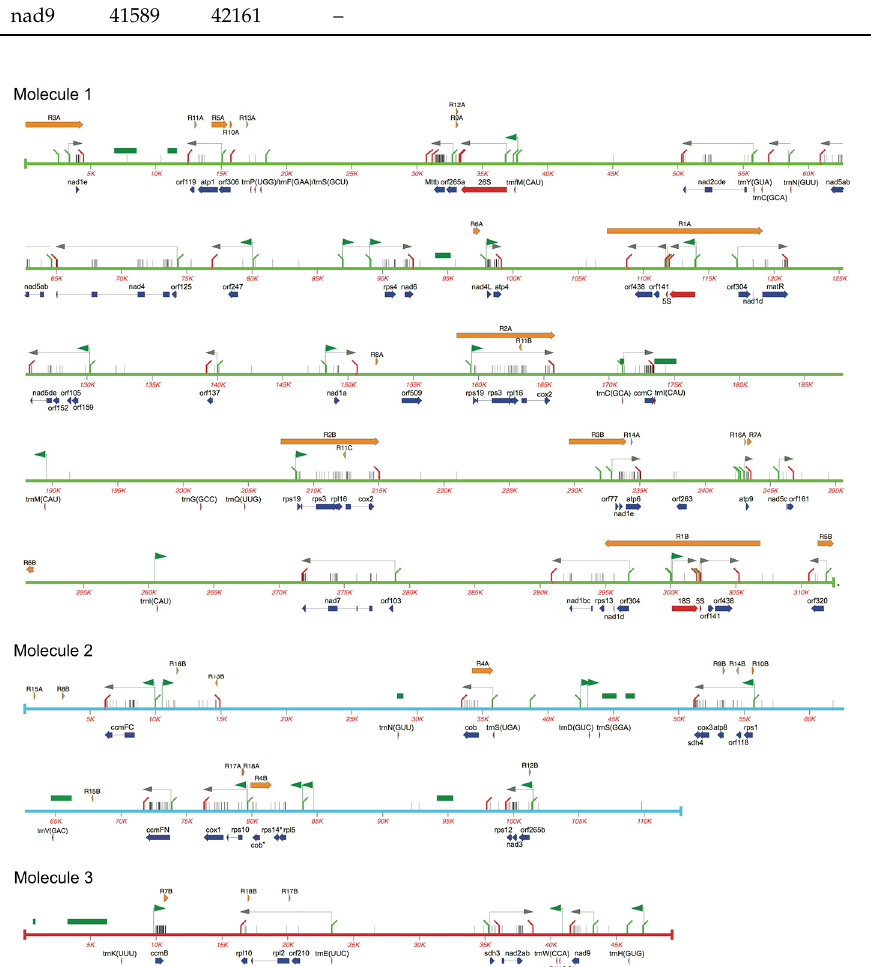
Figure 2. Organization of the potato mtDNA. Molecules 1, 2 and 3 are represented in green, light blue and red respectively. Gene sequences are shown below the sequence line, with protein genes in dark blue and rRNA and tRNA genes in red. Repeated sequences larger than 100 bp are shown above the sequence as orange arrows. Green bars indicate sequences of plastidial origin. Bent green and red lines indicate 5 ′ and 3 ′ transcript boundaries, respectively. Grey horizontal arrows represent major transcripts. Green horizontal arrows indicate consensus promoters found upstream of transcripts. Thin vertical lines indicate editing sites.